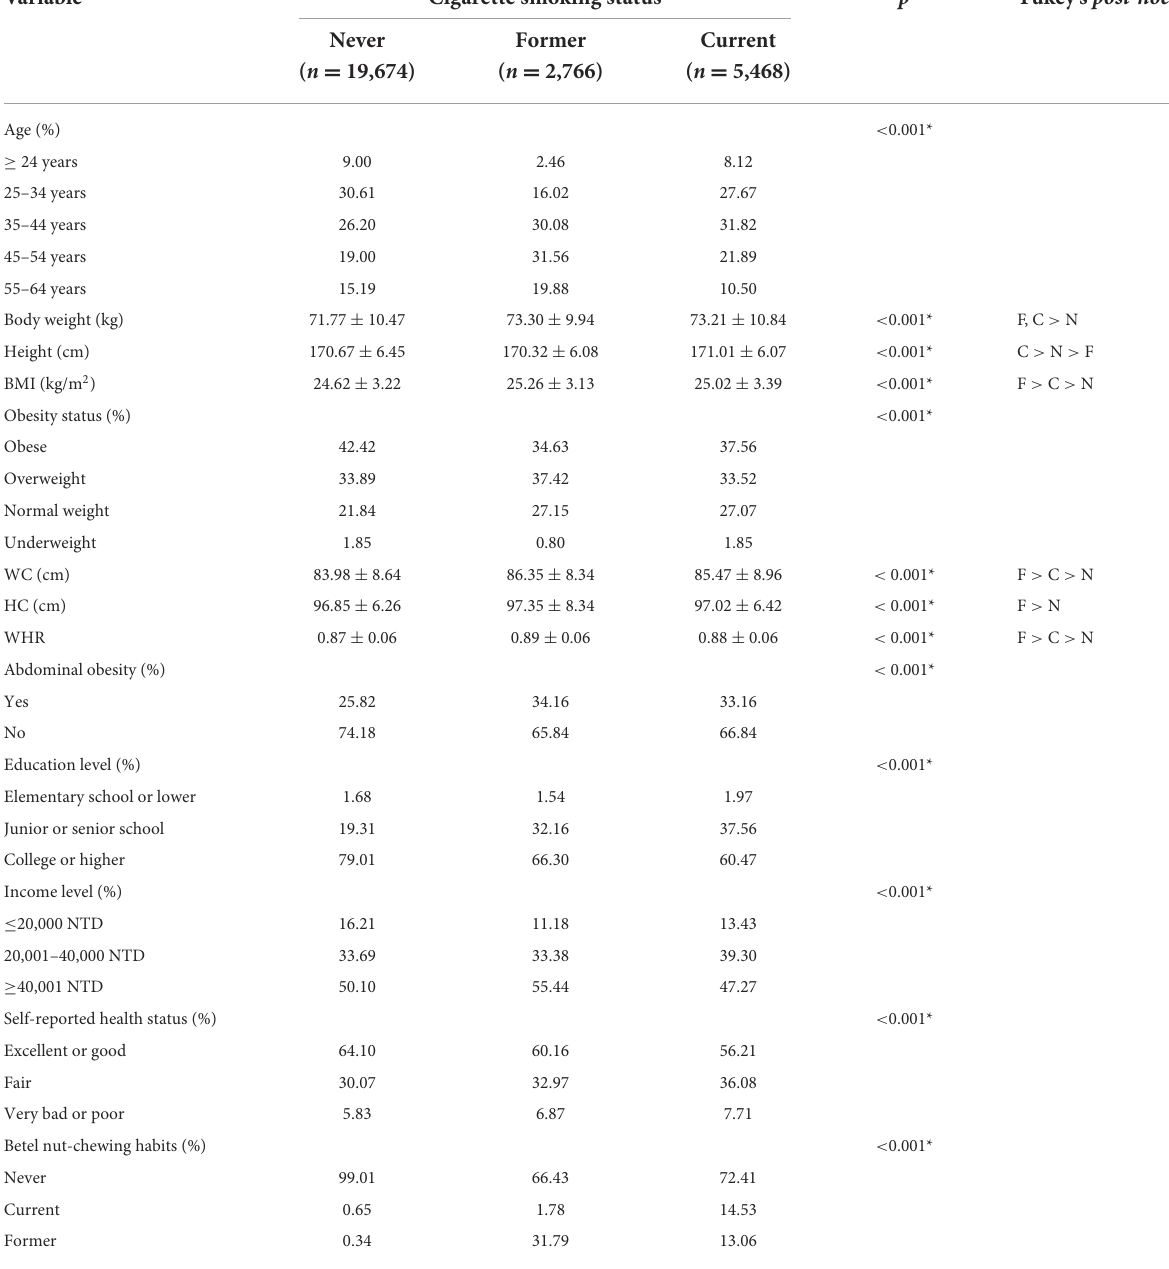
TABLE 1 Characteristics of the study participants according to cigarette smoking status among male Taiwanese